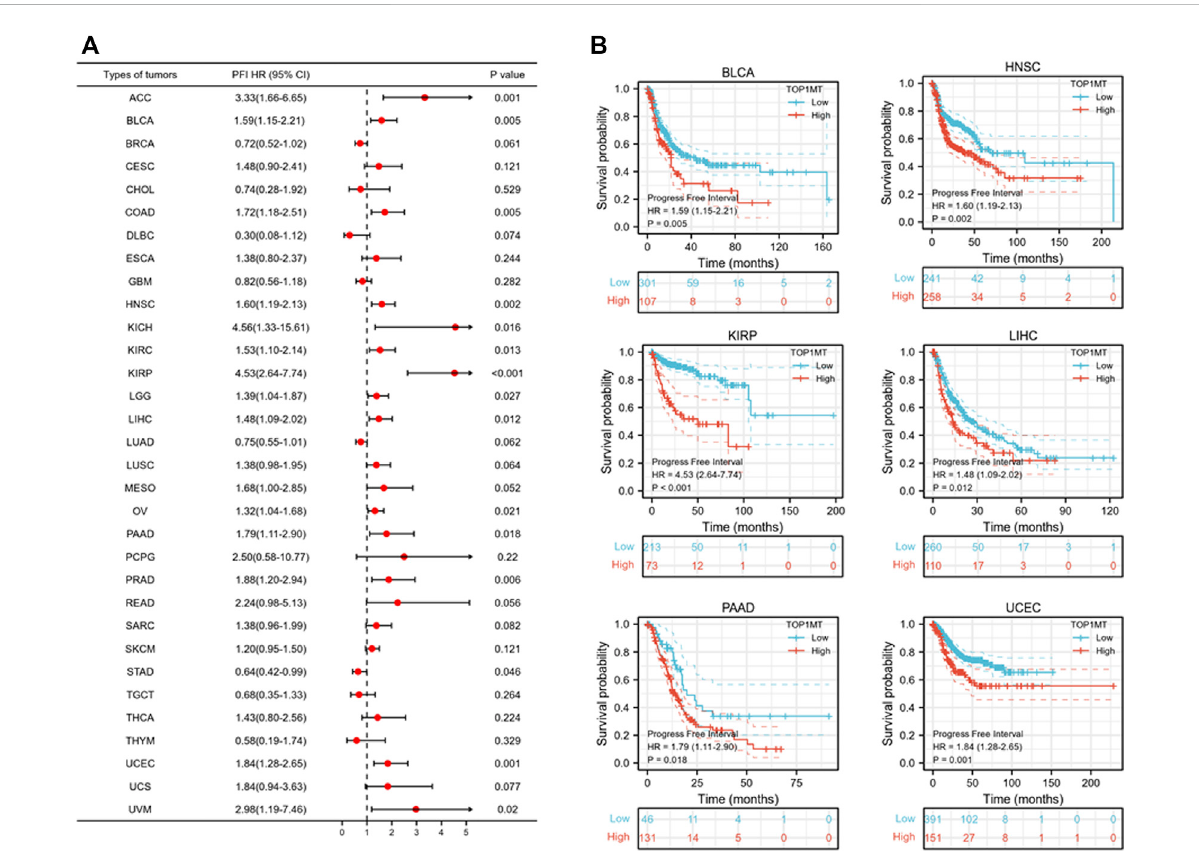
FIGURE 4 Relationship between TOP1MT expression and PFI in cancer patients. (A) Forest map of TOP1MT risk ratios in 33 tumors; (B) Kaplan-Meier survival curves of PFI in PATIENTS with BLCA, HNSC, KIPP, PAAD, UCEC, and LIHC. p p < 0.05, pp p < 0.01 and pp p <